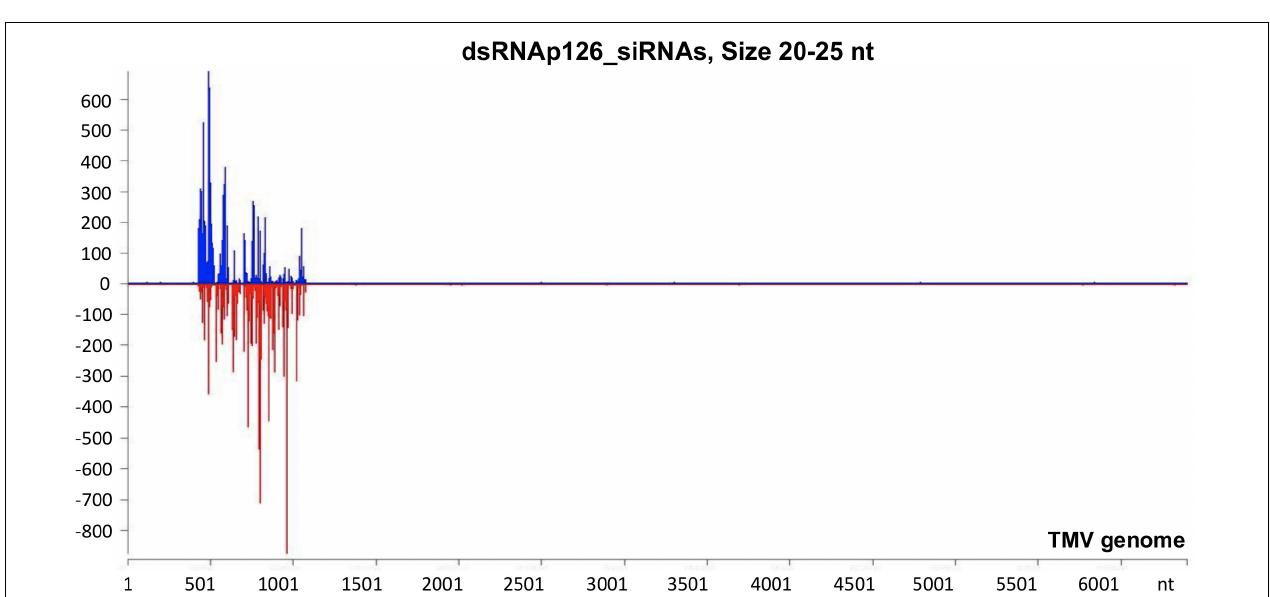
FIGURE 3 | Analysis of siRNAs derived from the exogenously applied dsRNAp126 employing small RNA next-generation sequencing (NGS) as early as 15 min post application (mpa). Only dsRNAp126 was applied to tobacco plants and NGS analysis was performed at samples collected at 15 mpa. MISIS software visualization shows the distribution of siRNAs of 20–25 nt length along the sequence of a TMV reference genome (NC_001367.1). It could be observed that siRNAs are produced only in the region 426–1,091 of the TMV genome. On the y -axis are shown the total read counts of siRNAs. Sense strand reads are shown with blue color above the x -axis, and antisense strand reads are shown with red color below the x